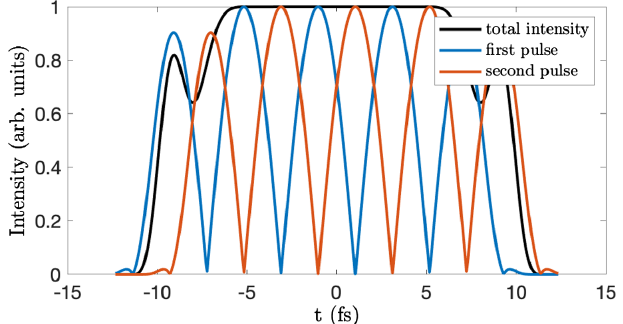
blue.FIG. 1. Example pulse intensity profiles from consecutive crossed undulators. Each pulse carries two colors separated by ℏ Δ ω ¼ 1 eV at ℏ ω ¼ 1 . 24 keV. The pulses from each undu- 0 lator are interleaved with a time delay of Δ t ¼ π = Δ ω ¼ 2